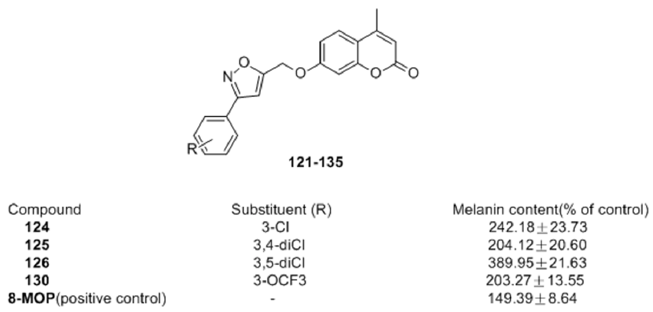
Figure 21. Structures of the coumarin derivatives bearing isoxazole moieties.